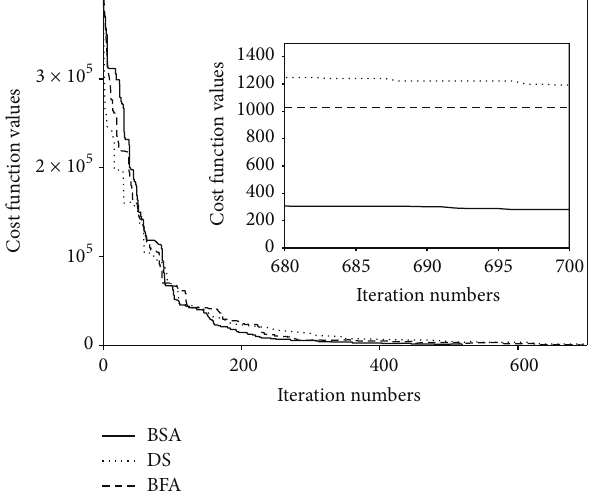
Figure 12: The convergence curves of BSA, DS, and BFA . pattern nulling examples, double (70 ∘ and 108 ∘ ) and triple ∘ ∘ ∘ , 70 , and 109 ) nulls are placed by using BSA on the (53 sidelobe region of the CCAA pattern. Figures 19 and 20